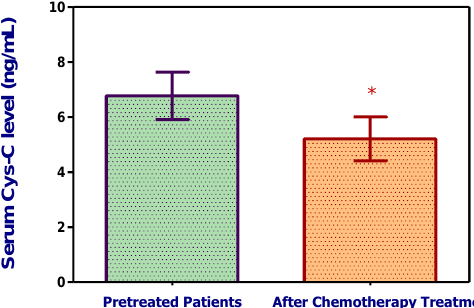
Figure 2. Bar chart shows the difference in the mean serum cystatin C (Cys-C) levels and 95% confidence level in the before-chemotherapy group and the after-achieving-remission group (paired group analysis of the 22 patients at the time of diagnosis and then after achieving remission). * Significant different ( p <